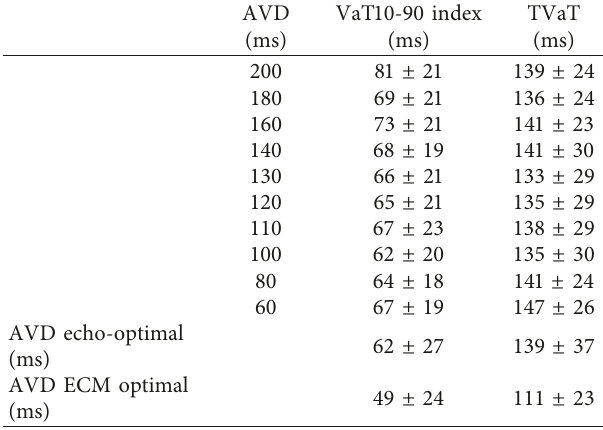
Values represent means ± SD. AVD, atrioventricular delay; echo, echo- cardiographic mapping; ECM, electrocardiographic mapping; TVaT, total ventricular activation Time; VaT 10-90 , ventricular activation time 10-90 . Values were compared by ANOVA and the Kruskal–Wallis test. No be- tween-group comparisons were significant (Tukey’s HSD).